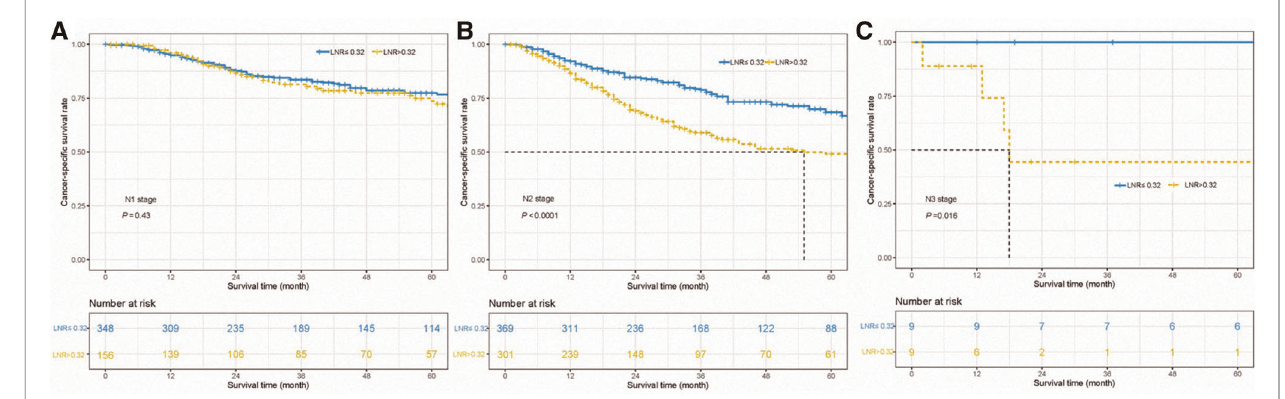
FIGURE 4 | Cancer-speci fi c survival curves for parotid gland cancer patients with stage N1 ( A ), N2 ( B ), and N3 ( C ) according to the lymph node ratio in the cohort of Surveillance Epidemiology and End Results database and Sun Yat-sen University Cancer